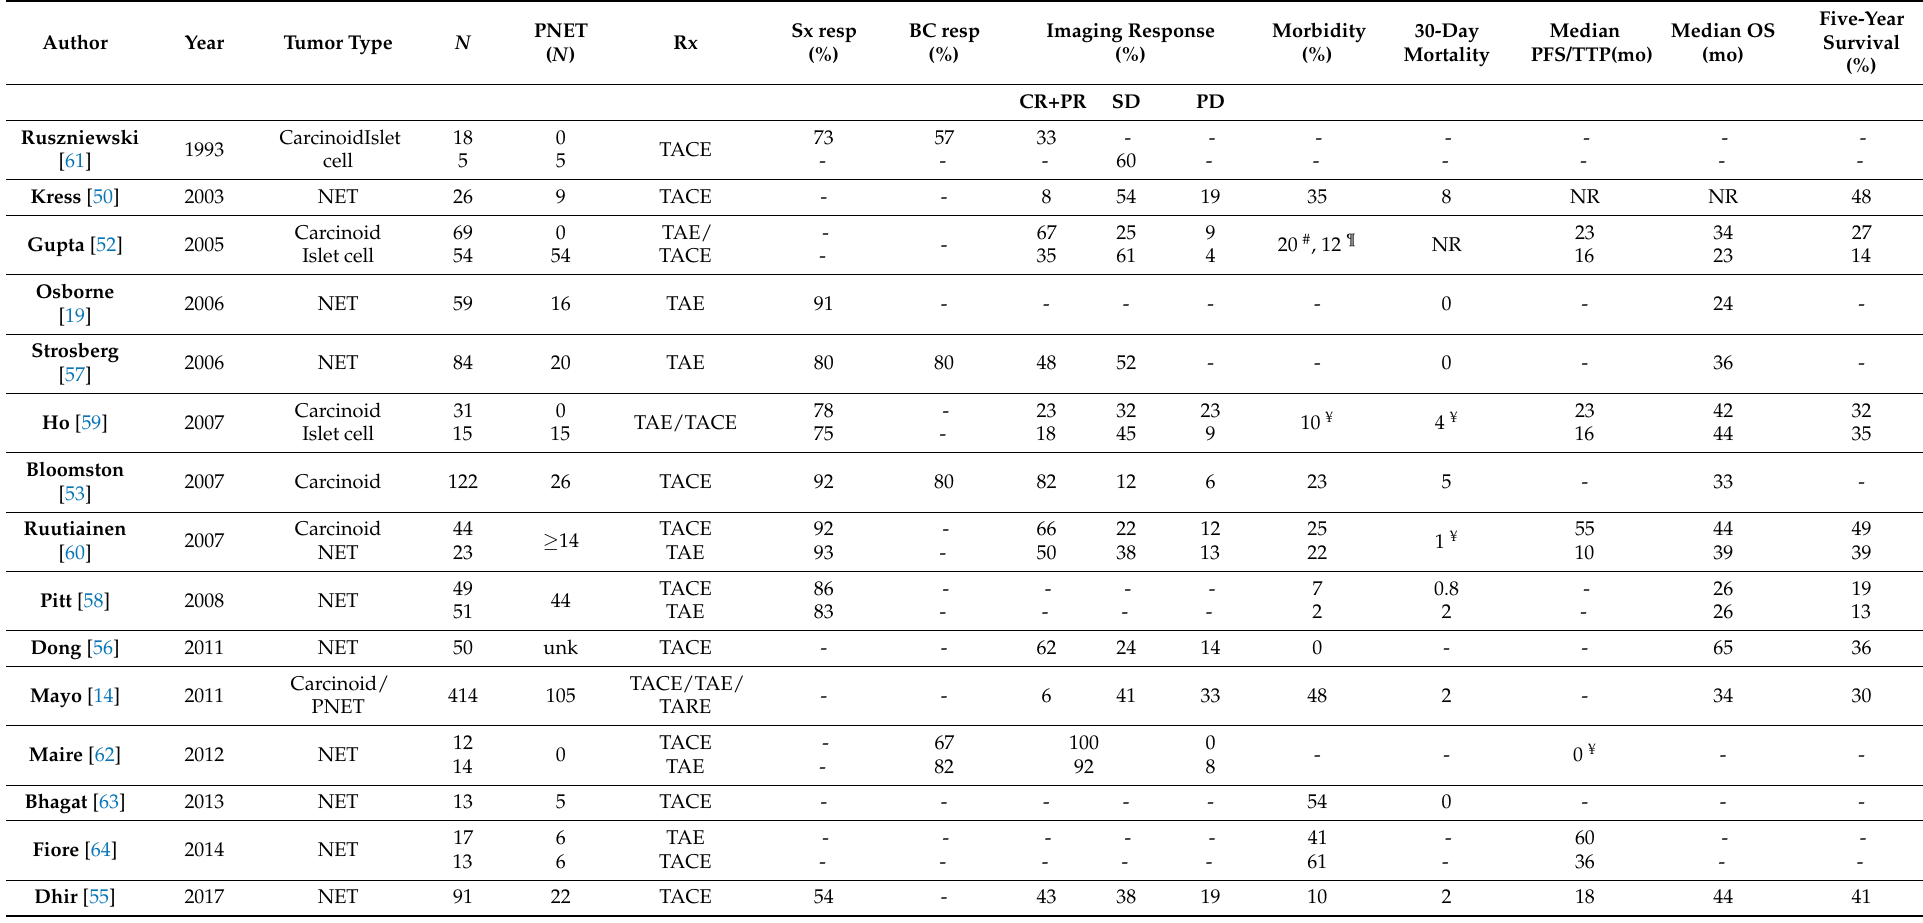
Table 2. Study outcomes of transarterial embolization (TAE) and transarterial chemoembolization (TACE) in patients with neuroendocrine liver